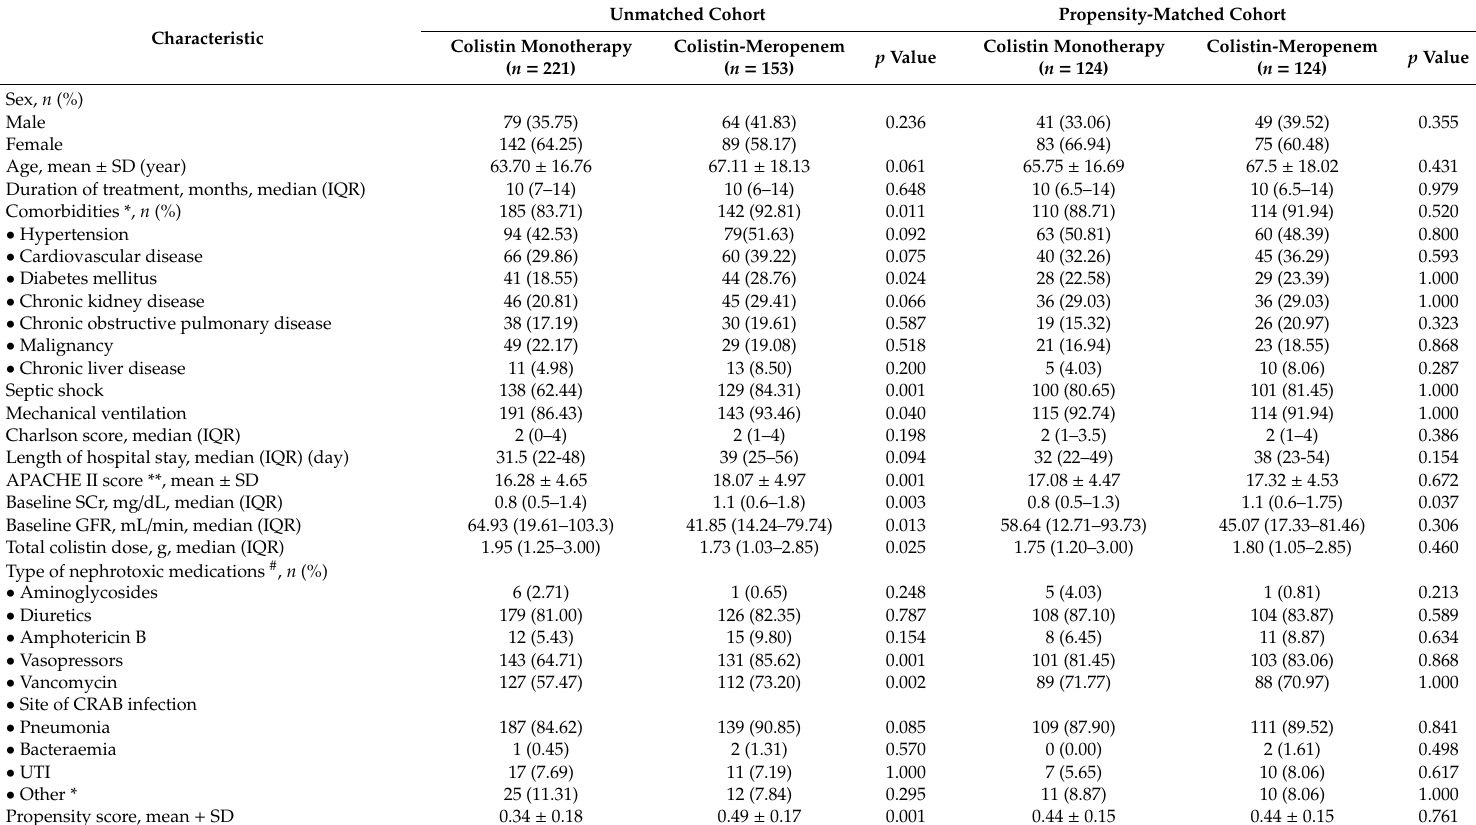
Unmatched Cohort Propensity-Matched Cohort Colistin Monotherapy Colistin-Meropenem Colistin Monotherapy Colistin-Meropenem p Value p Value ( n = 221) ( n = 153) ( n = 124) ( n = 124)